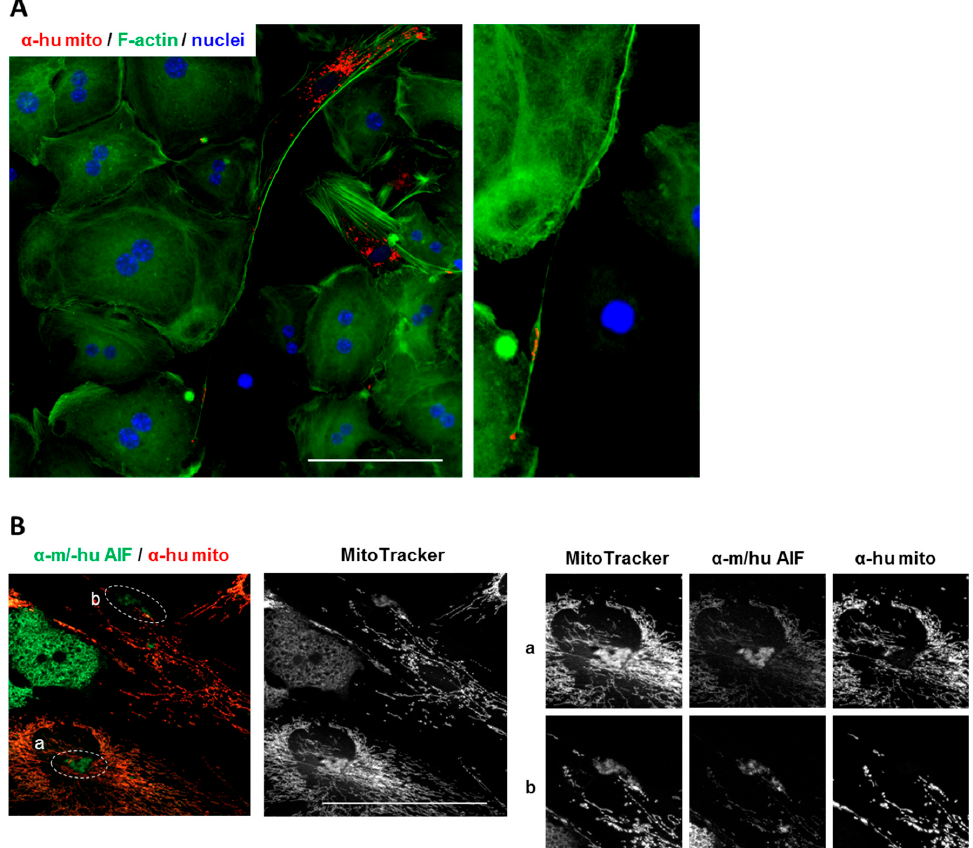
Figure 6. TNTs between HCs and MSCs are used to transport mitochondria. ( A ) Human MSC-derived mitochondria, stained in red with the anti-human-specific antibody against human mitochondria, are delivered to co-cultured mouse hepatocytes (mostly bi-nucleated). F-actin was stained with Phalloidin- iFluor 488 (green), nuclei with DAPI. Scale bar; 100 μ m. Right panel: Computational enlargement of an area as shown on the left panel; ( B ) Mouse and human mitochondrial apoptosis-inducing factor (AIF) (green) and human mitochondria (red) were detected by fluorescent immunocytochemistry using species-specific antibodies, and cells were further stained with MitoTracker™ Deep Red FM (white). ( a ) and ( b ) show higher magnification pictures (computational enlargements) of circled areas shown in the panels on the left. Scale bar100 μ m.